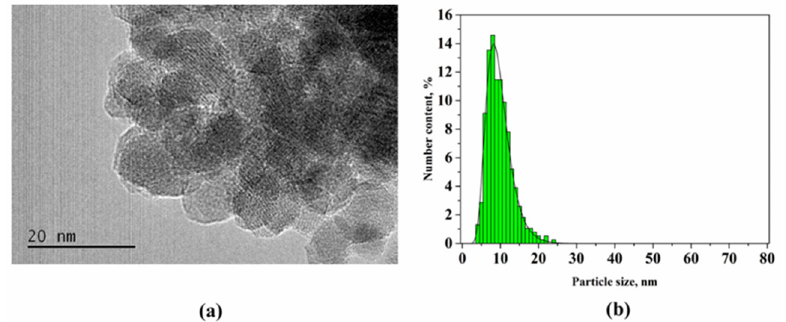
Figure 8. ( a ) TEM image of the five-minute reaction product for magnetite synthesized by coprecipitation method, and ( b ) particle size distribution histogram. Reprinted with permission [93]. Copyright 2021, American Chemical Society.